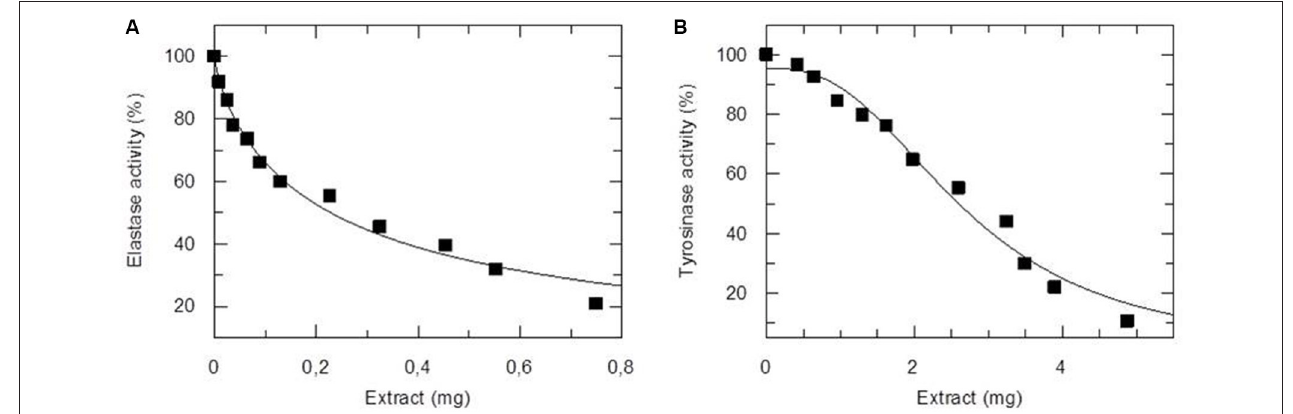
FIGURE 1 | Inhibitory activity of NannoG on elastase (A) and tyrosinase (B) activity. The amount of extract used in enzyme assay was expressed as mg of dry weight. The IC50 values were 0.23 ± 0.02 and 2.69 ± 0.13mg against elastase and tyrosinase, respectively.